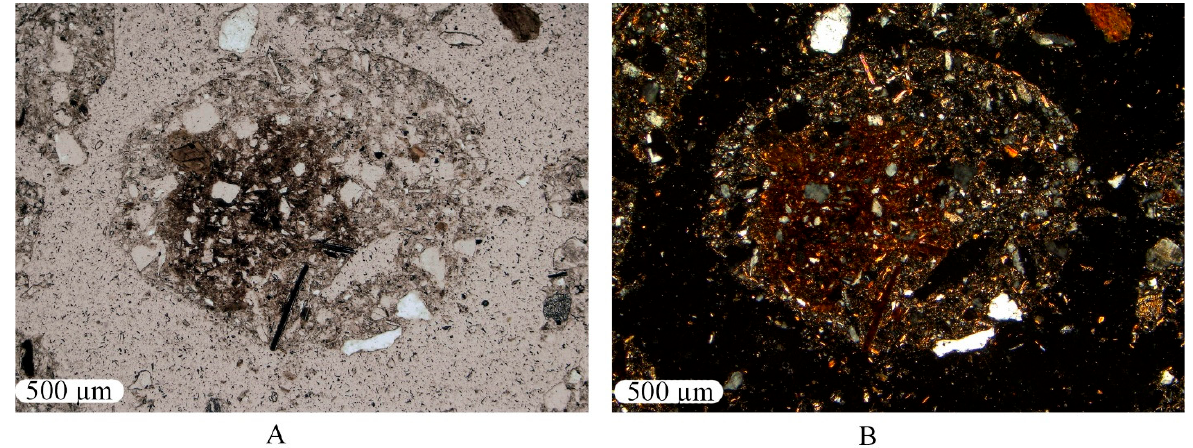
Figure 8. Micromorphological structure of the arable soil Y12 Btz profile. ( A ) plane polarized light; ( B ) crossed polarized light.